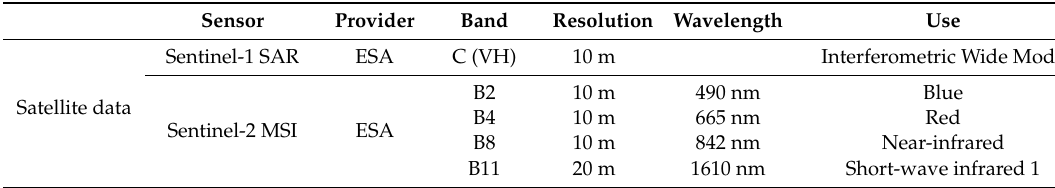
Table 1. Characteristics of the satellite data used in this